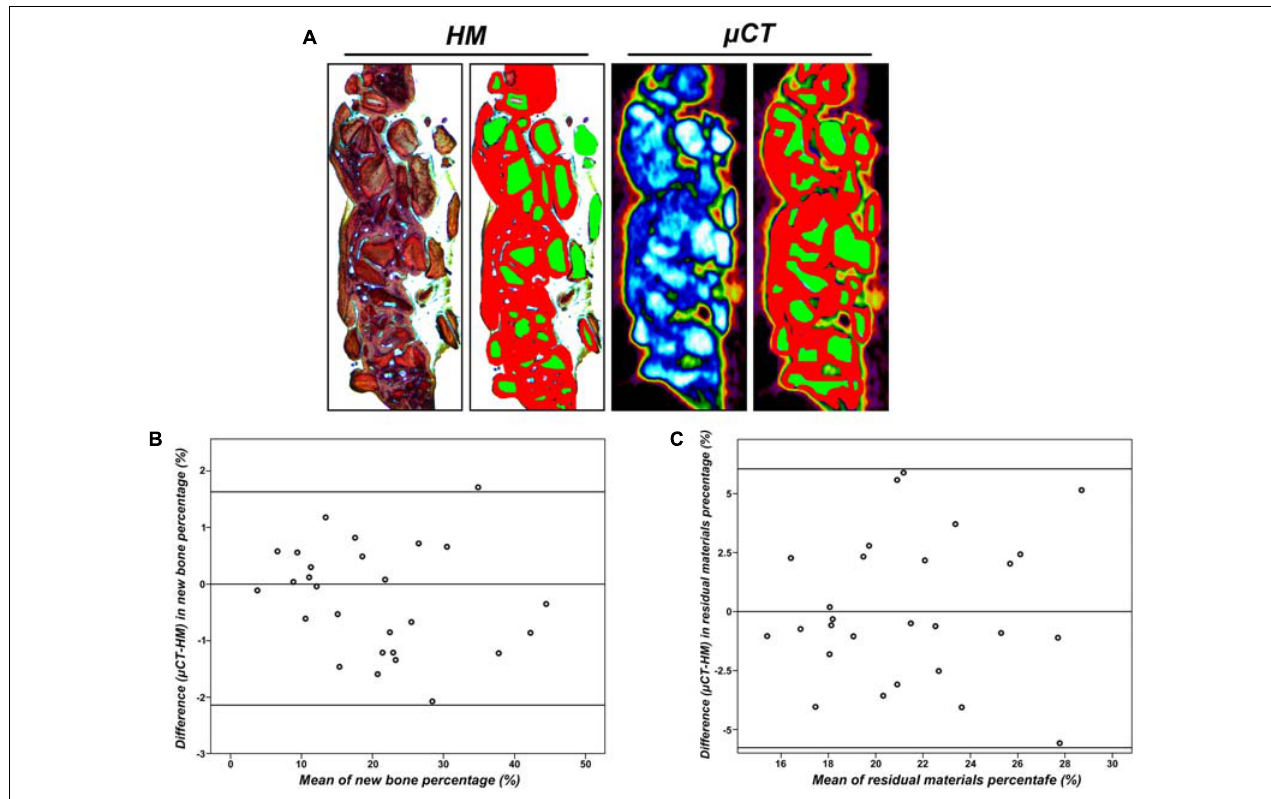
FIGURE 6 | (A) View as used for radiographical and histomorphometrical analyses in the µ -CT or histological slices. Red, newly formed bone; green, residual particles ( × 10). (B) Agreement between µ CT and histomorphometry (HM) for the measurement of new bone percentage (%). (C) Agreement between µ CT and HM for the measurement of residual particle percentage